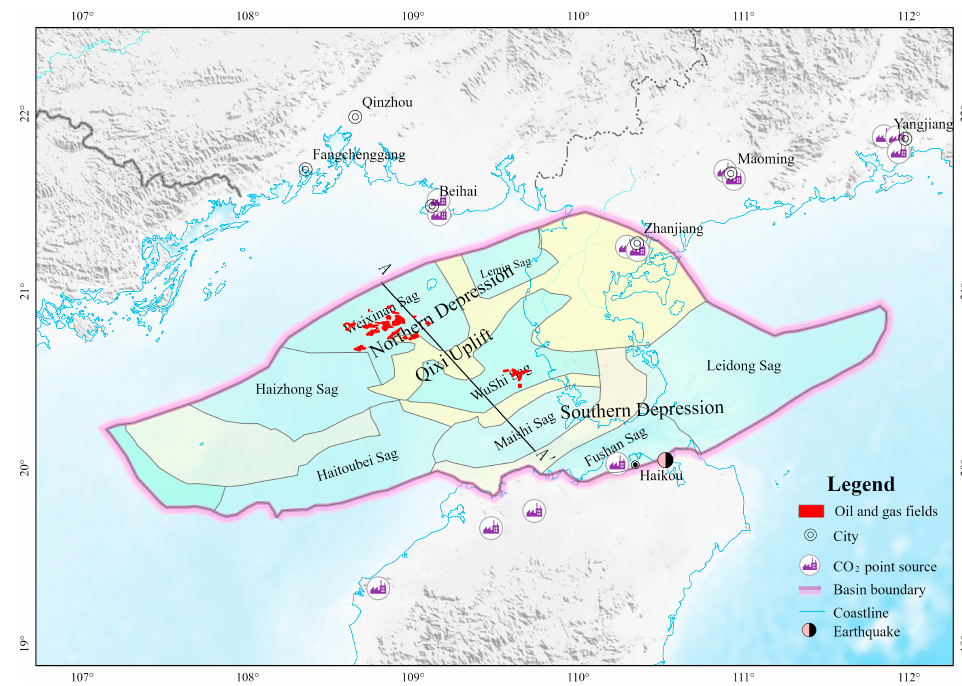
Figure 1. Simplified geological map of the Beibu Gulf Basin (modified after [28,29]) showing locations of structure units, oilfields, earthquake epicenters, and CO 2 emission point sources.